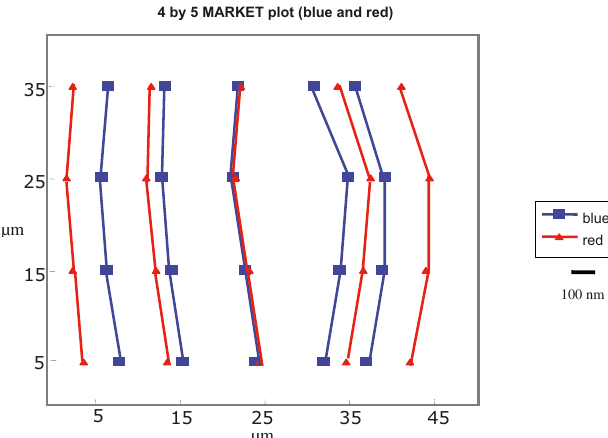
Fig. 6. MARKET plots (4 by 5) under blue light and red light illumination. The scale bar at right measures the phase differ- ence of each subfield under blue light and red light illumination, with the units of phase expressed in